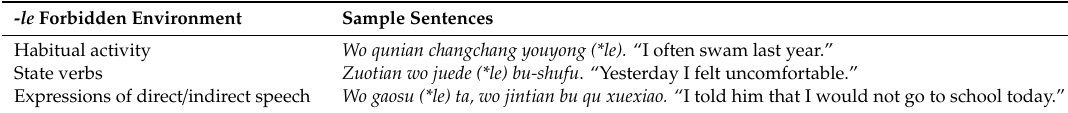
Table 1. Forbidden context of - le and